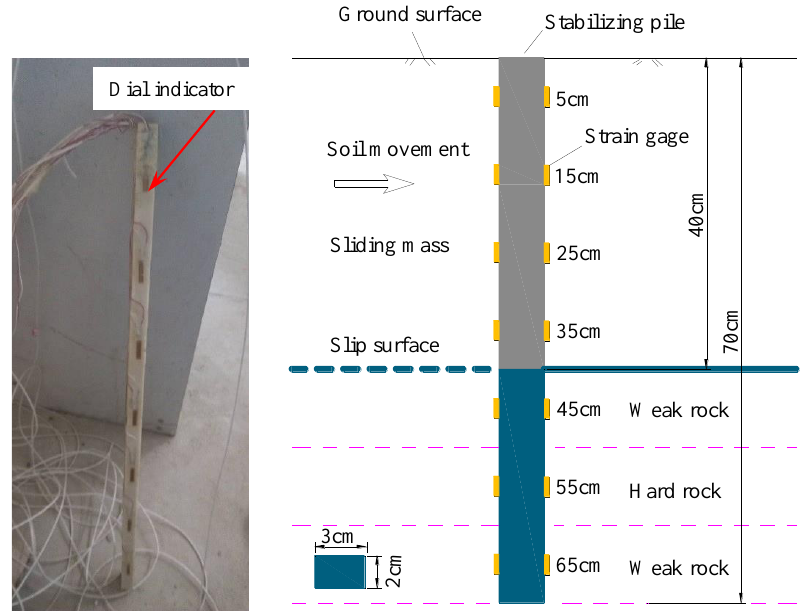
Figure 3. Layout of the strain gauges on the stabilizing pile model (yellow color markers are for strain gage).